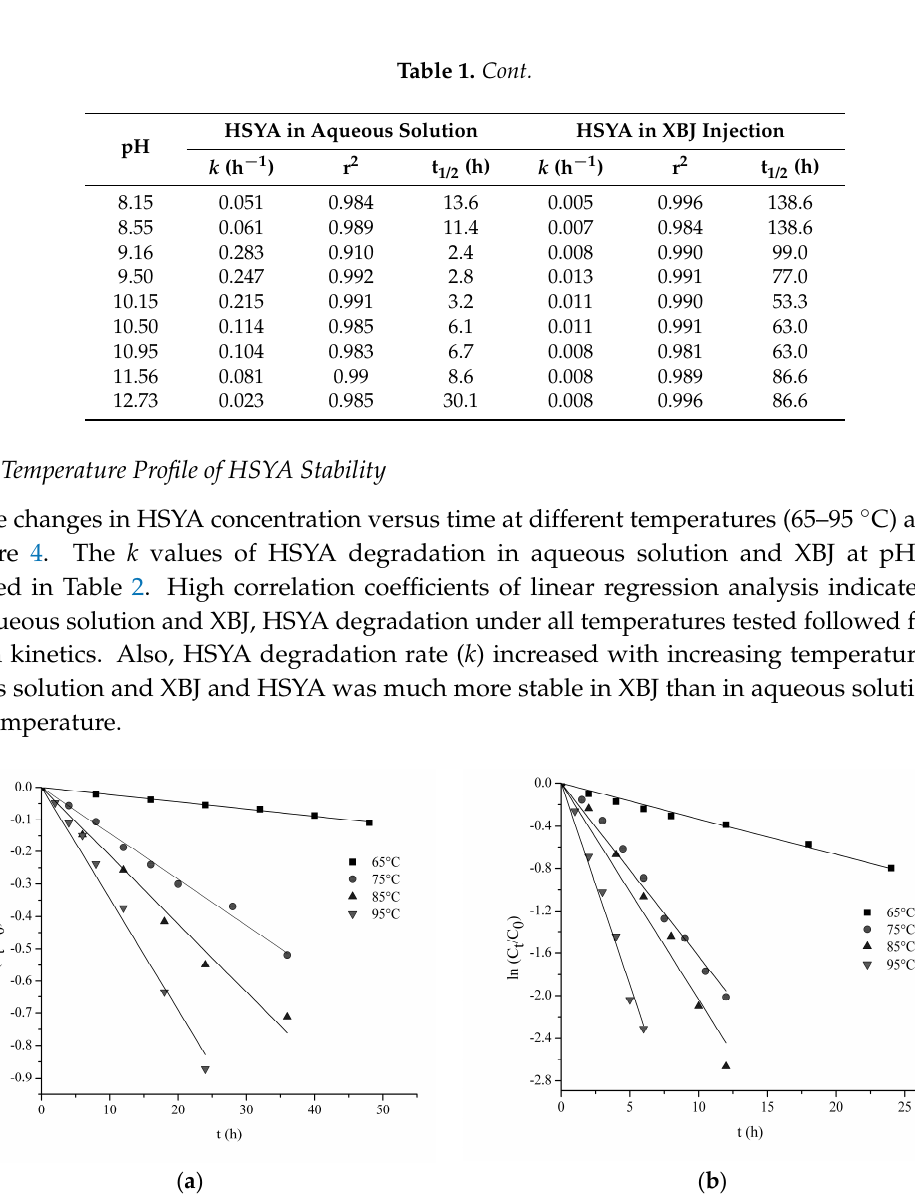
Table 2. Kinetic parameters of HSYA degradation at different temperatures.